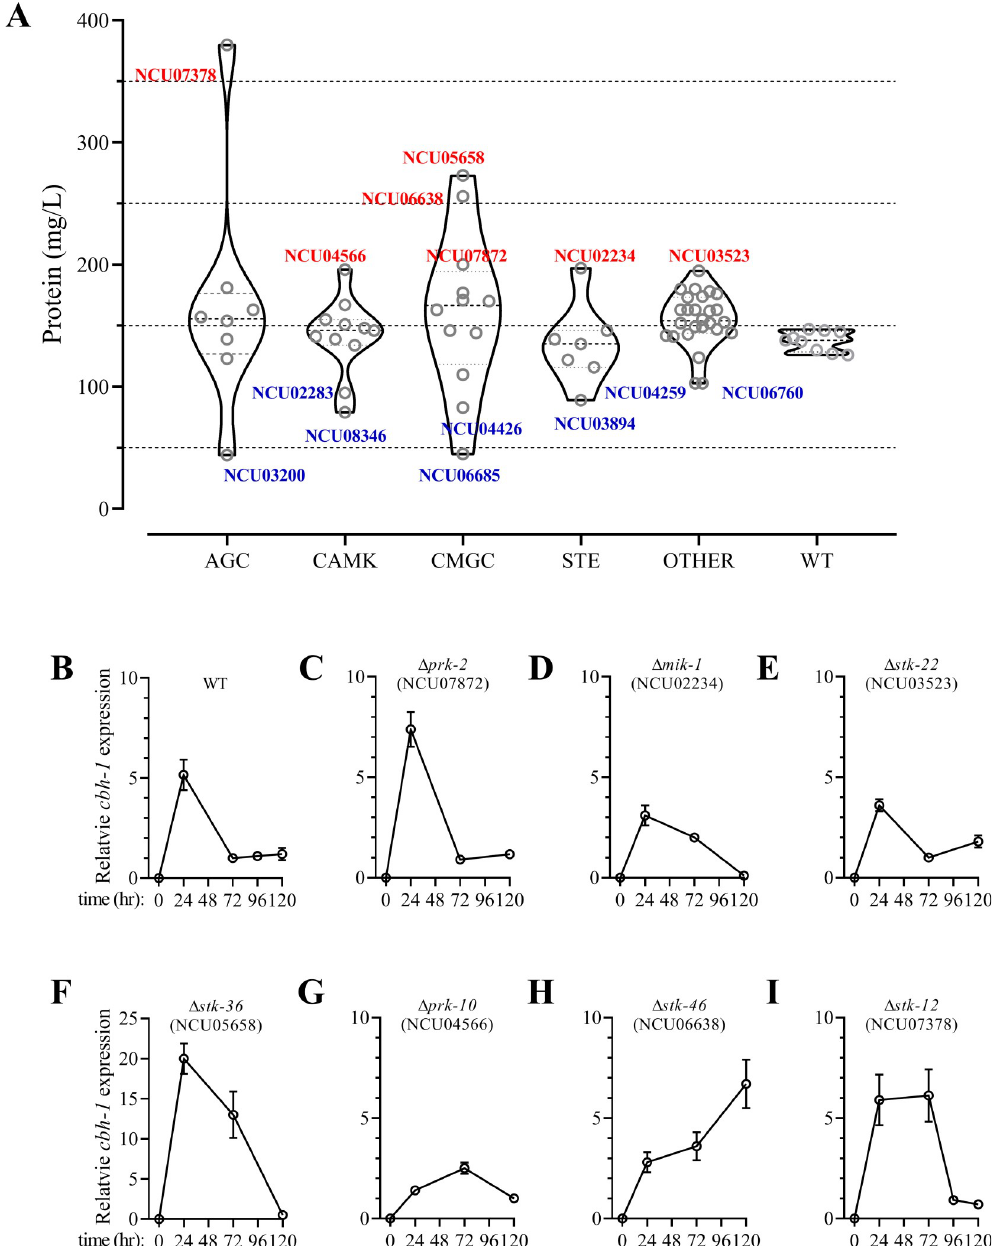
Fig 1. Screening of serine/threonine protein kinase mutants of Neurospora crassa . (A) Total secreted protein assay was performed on 64 deletion strains as compared to wild-type (WT) strain. Conidia from WT and kinase mutants were separately inoculated into Avicel medium and batch cultured for 5 days. Strains with altered cellulase production ( > 25%) are indicated as follows: Red, hyper-producing strains; Blue, hypo-producing strains. Serine/threonine protein kinases can be grouped into different families based on catalytic domains: AGC, CAMK, STE, CMGC, and OTHER. (B)-(I) Relative transcript levels of major cellulase gene ( cbh-1 ) in hyper-producing mutants versus WT after 1–5 days growth on Avicel. After growth of conidia in Avicel for 24, 72, or 120 h, transcript abundance of cbh-1 was evaluated by quantitative real-time PCR. Data are normalized against tested gene’s transcript level in WT strain at 72 h. Actin (NCU04173) transcript levels were used as endogenous control in all samples. Values represent means of at least three biological replicates; error bars show standard deviation.